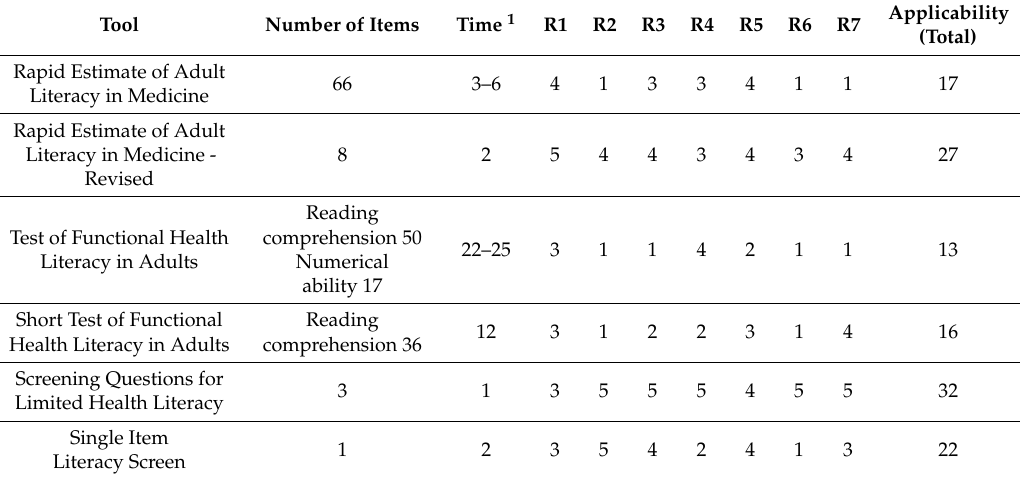
Table 1. Results of evaluation of studies by seven